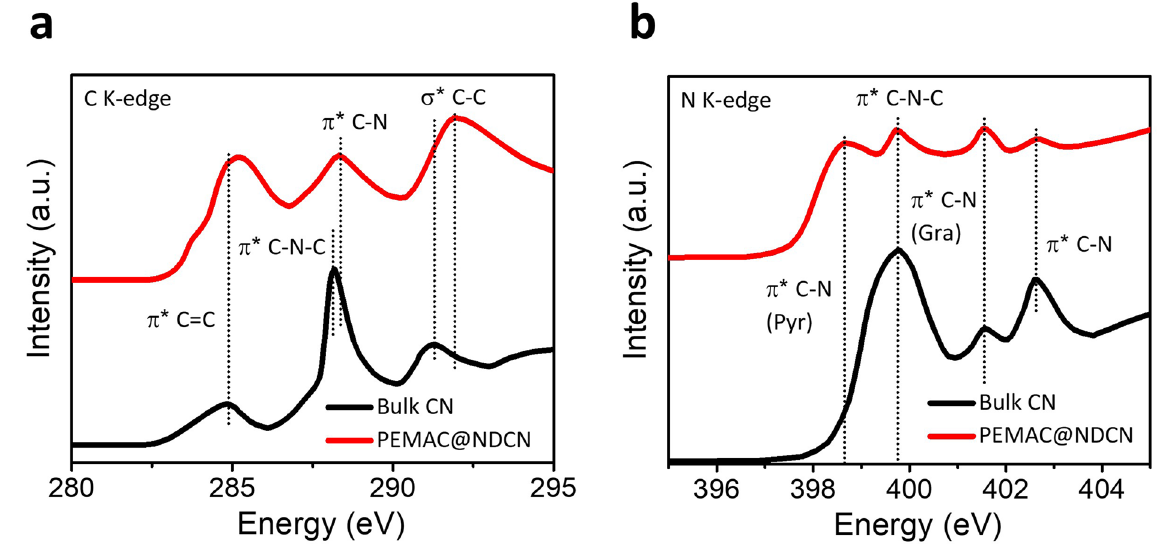
Fig. 4 X‑ray absorption spectroscopic characterizations. XANES spectra of a C K‑edge and b N K‑edge for the PEMAC@NDCN and bulk CN